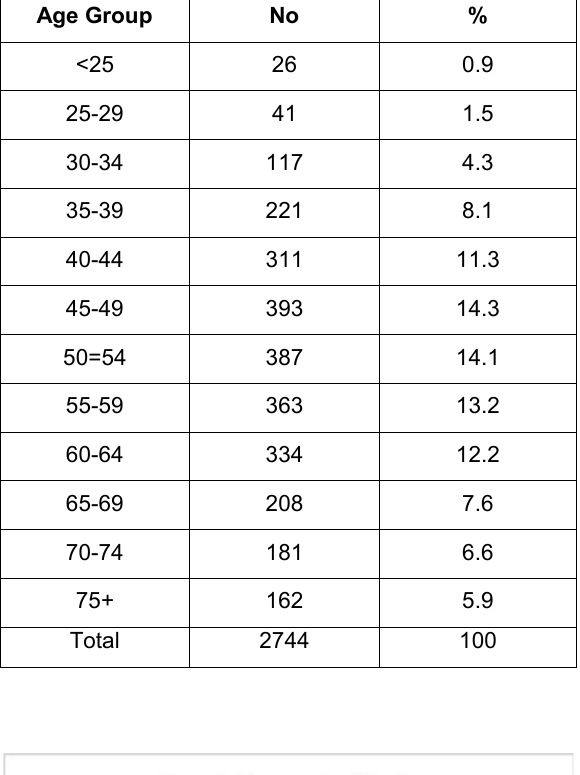
Figure 5. Breast Cancer Age Standardized Incidence Rates of